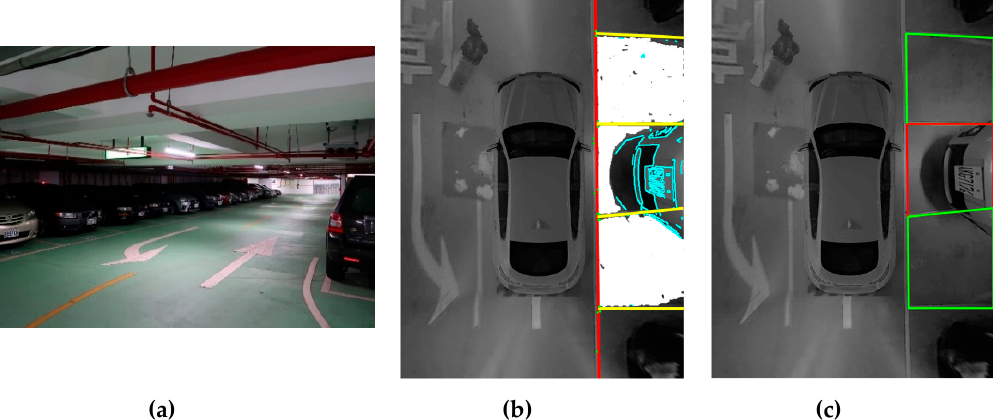
Figure 22. Experimental results in the indoor parking lot at the National Taipei University of Technology. ( a ) Experimental setting; ( b ) Detection process; ( c ) Detection results. Table 1. Parking space features at the National Taipei University of Technology.